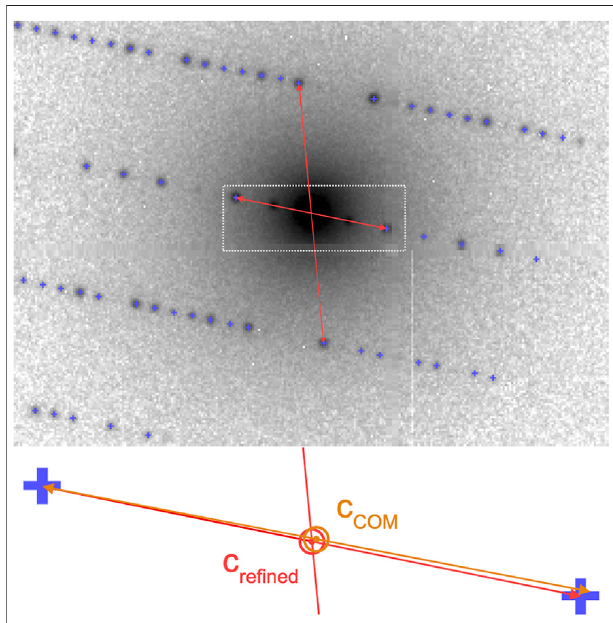
FIGURE 4 | Pattern center re fi nement from Friedel mates. In electron diffraction patterns, even away from zone axes, a large number of Friedel mates is simultaneously visible, such as those marked by arrows. As they are symmetric about the zero-order beam, the positions of each pair can be → used to re fi ne the initial estimate c COM of the pattern center to the more accurate c